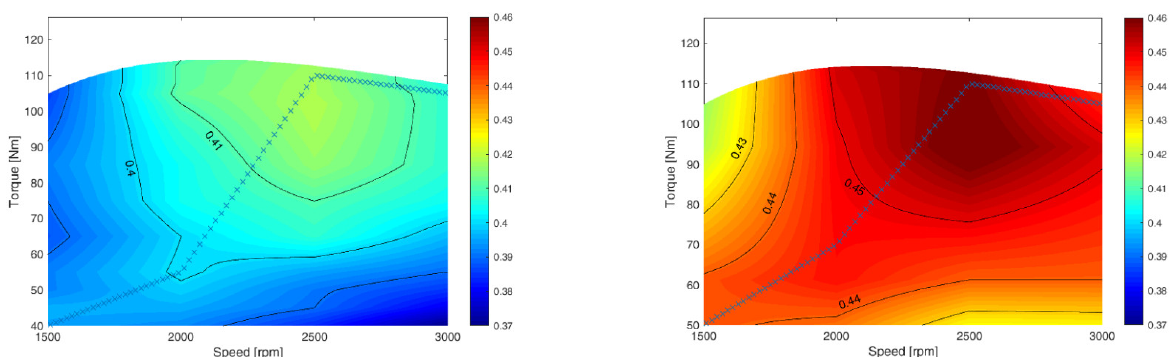
Figure 35. 40 kW Diesel ( left ) and Diesel + TC ( right ) efficiency contour map. ICE working points in series architecture are shown.